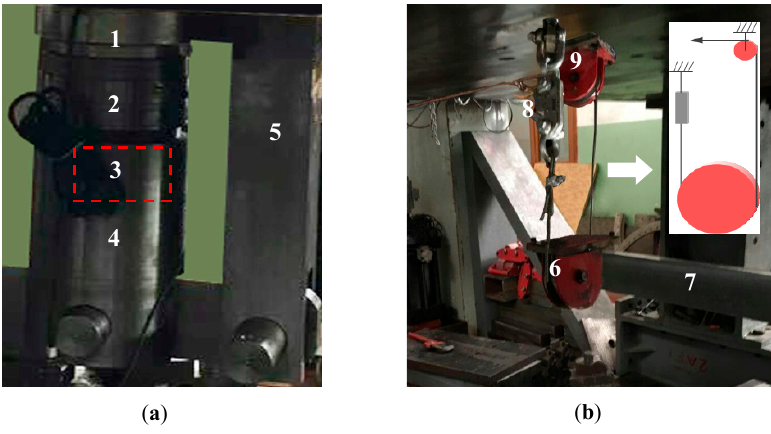
Figure 15. ( a ) The sensors and the adjacent devices shown in Figure 14; ( b ) Pulley mechanism shown in Figure 14. ( 1 )-Vibrating wire sensor; ( 2 )-Piezoelectric sensor; ( 3 )-Lockset (ii); ( 4 )-Lug (iv); ( 5 )-Support (ii); ( 6 )-Pulley (i); ( 7 )-Beam (ii); ( 8 )-Quick-release hook; ( 9 )-pulley (ii).